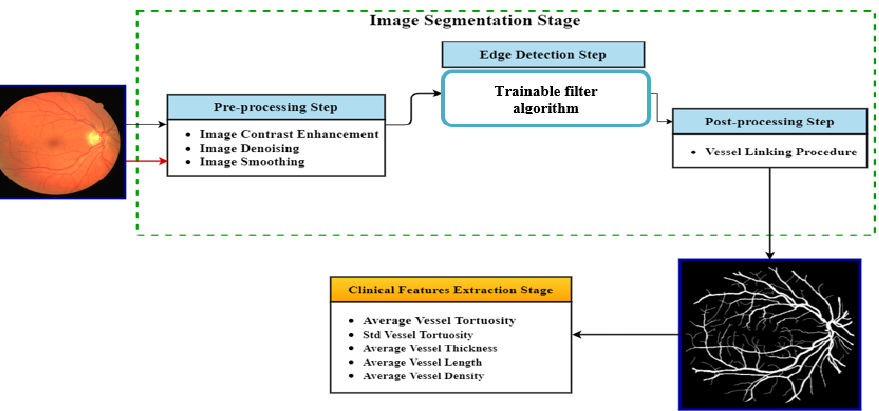
Figure 1. Block diagram of the proposed blood vessel segmentation and clinical features measure- ment algorithm.